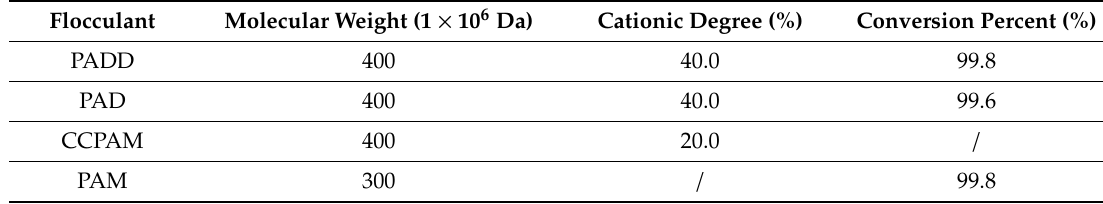
Table 1. Flocculants used for characterization and flocculation test.